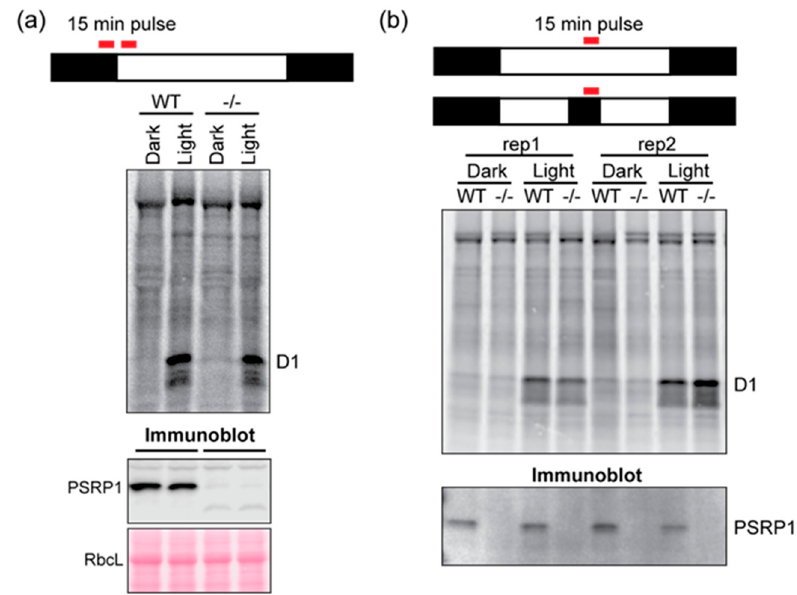
Figure 4. Pulse-labeling analysis of Zm- psrp1-2 mutants in light and dark. Seedlings were pulse-labeled for 15 min at the end of the night (8 h dark) and after 15 min of illumination at dawn ( a ) or at midday (8 h in the light) or after one hour in the dark ( b ). Total leaf proteins were resolved by SDS-PAGE and transferred to nitrocellulose for phosphorimaging. The nitrocellulose was subsequently analyzed by immunoblotting (bottom panels) to validate the absence of PSRP1 in the mutant samples (- / -). WT siblings served as the control for the experiment performed at dawn, and the inbred line B73 served as the control for the experiment performed at midday.